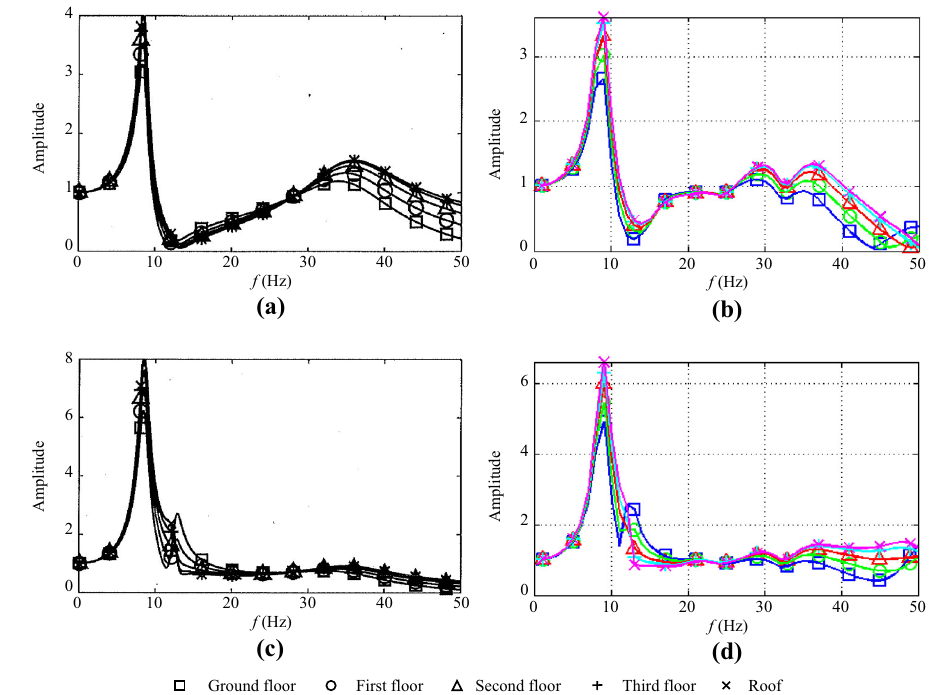
Fig. 13 Soil–building transfer functions of the four-storey office building: a , b column; c , d floors; a , c prediction model; b , d finite-element